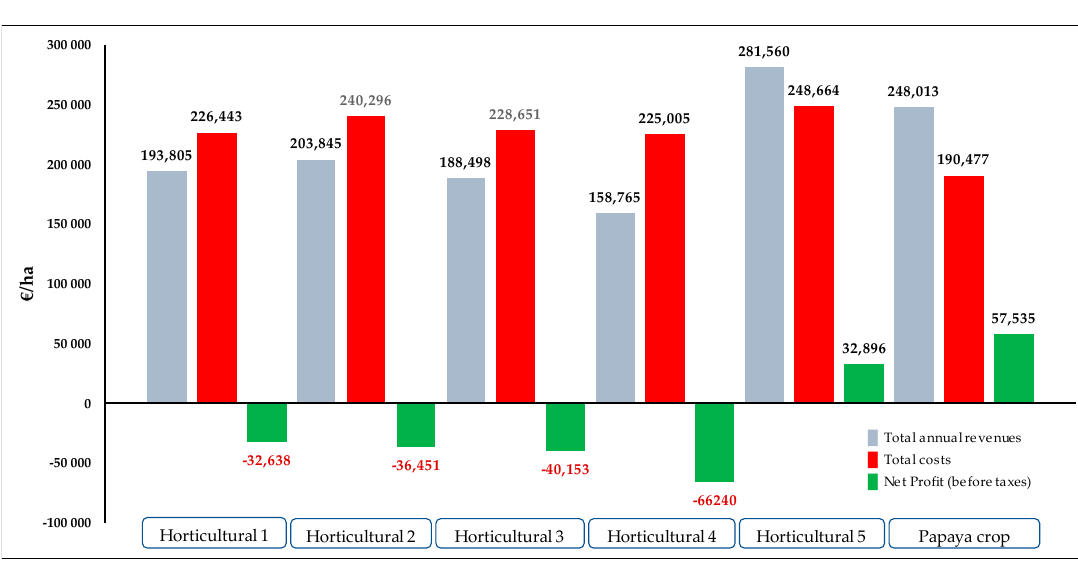
Int. J. Environ. Res. Public Health 2019 , 16 , x